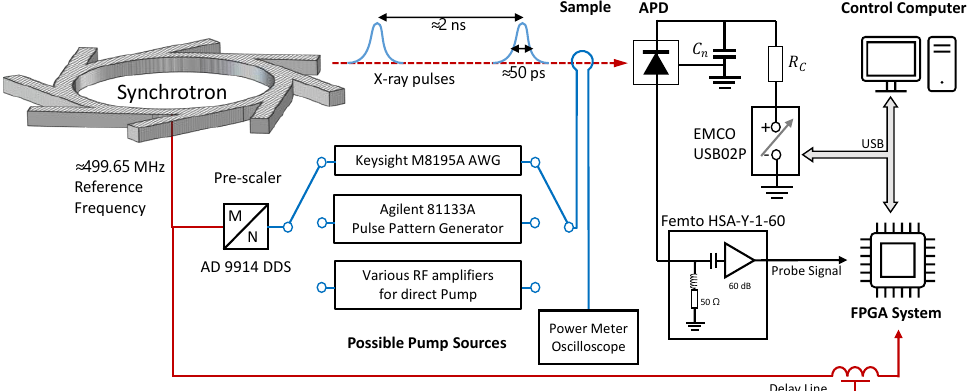
Figure 5. Simplified schematic overview of the TimeMaxyne setup. The storage ring frequency is used as a time base of both excitation and detection branch of the pump-and-probe setup. The APD bias voltage is applied using a precision high voltage power supply, while pulses from the APD induced by X-ray photons are amplified by 60 dB and recorded by the FPGA board, which communicates via USB with the control computer. Multiple excitation setups can be switched in, and the transmitted signal is analyzed on real time oscilloscopes or high bandwidth power meters.